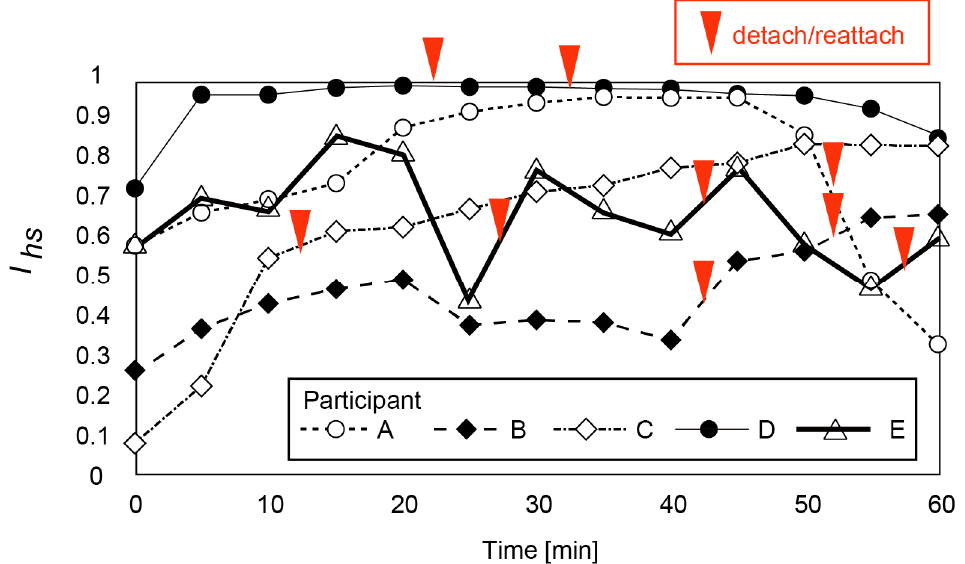
Figure 10. Variation of headset discomfort I hs for five participants. Observed detach- ment/reattachment times are also shown. For participants B after 40 and 50 min and participant E after 25, 40 and 55 min, detachment/reattachment of the headset resulted in an increase of I hs